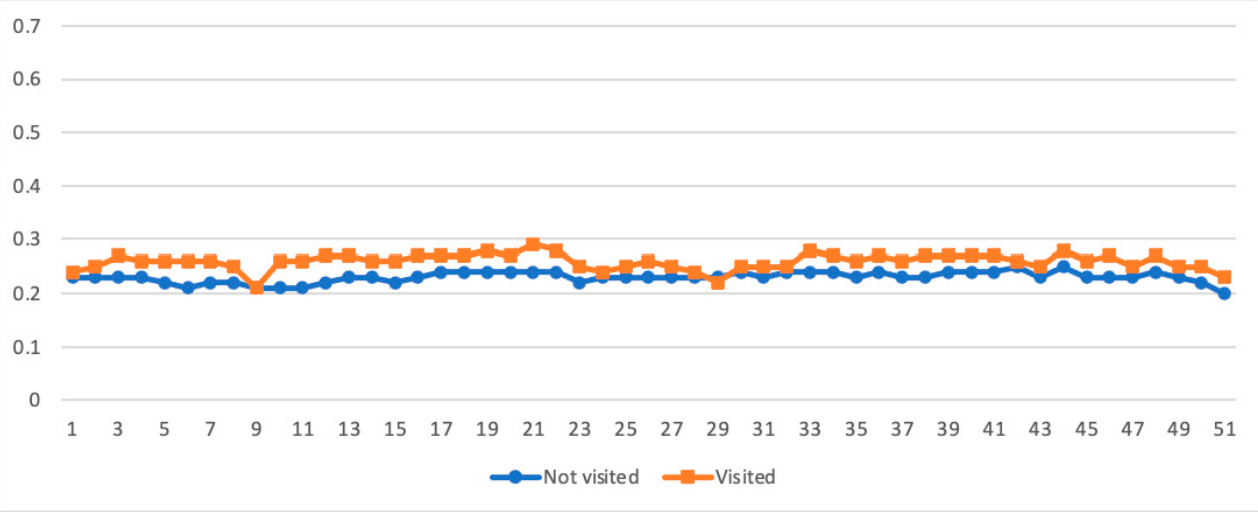
Figure 5. Weekly negative emotion levels on the r/Teenagers subreddit by youth who visited and never visited the mental health subreddits.